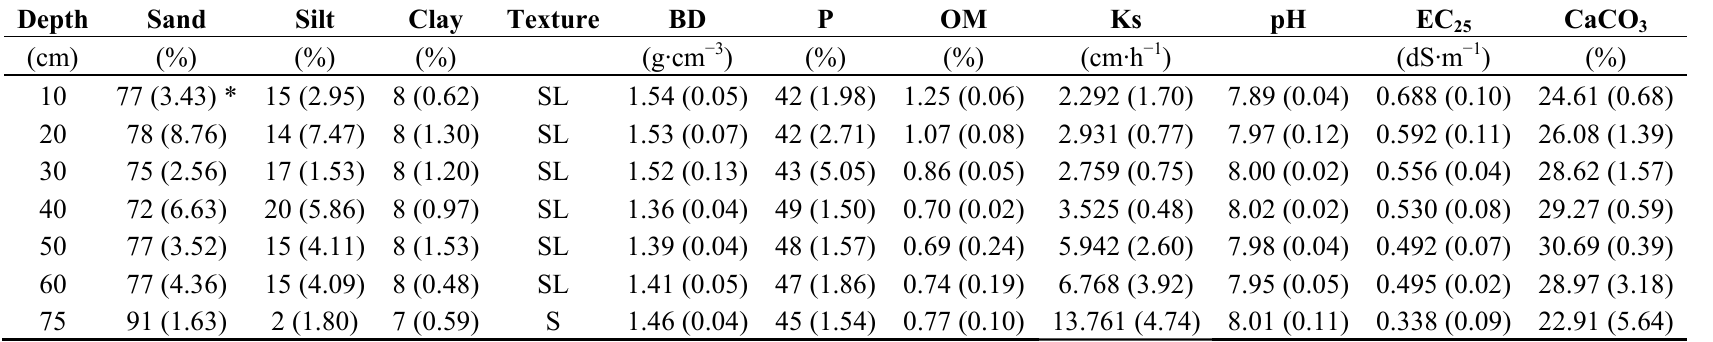
Table 1. Some physical and chemical properties of experimental field soil.